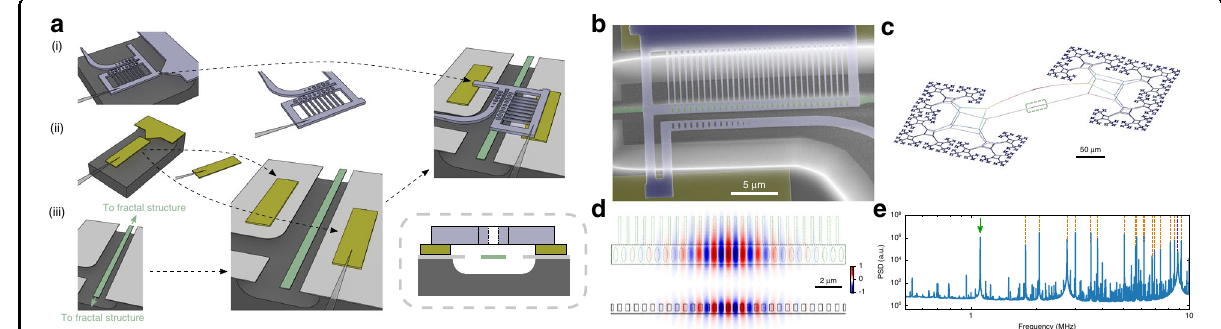
Fig. 1 Optomechanical device. a Device assembly process. We start with three chips, on which the different structures are fabricated from thin fi lm silicon nitride. They are patterned with (i) a photonic crystal, (ii) spacers, and (iii) center part of a mechanical structure, respectively. A fi ber is used to fi rst pick up the spacers and place them on the mechanical chip. Then the photonic crystal is stacked on top of the spacers. The sketch in the box at the bottom-right shows the cross-section of the fully assembled structure. The thickness of the spacers determines the gap distance between the photonic crystal and the mechanical resonator. b False-colored SEM image of the assembled device. c Simulation of the fundamental out-of-plane mechanical mode of the fractal structure. The mechanical motion is gradually damped from the center to the clamping points. The green dashed box highlights the part of the mechanical structure shown in ( a ) and ( b ). d Electric fi eld distribution (top) on the upper surface of the mechanical layer and (bottom) on the center vertical plane. The green dashed line on the upper plot shows the projection of the photonic crystal. The mechanical layer in the simulation has a width of 1 µm, matching the width of the photonic crystal. e Measured power spectral density (PSD) of an assembled device, showing how clean the spectrum is around the fundamental mode, with negligible excess noise from other modes. The PSD is measured using a balanced homodyne detection scheme. The green arrow indicates the fundamental high-Q M mechanical mode, the orange dashed lines the higher mechanical modes, while the mechanical mode of the photonic crystal is marked in purple. All other peaks are either electronic noise or mixing between modes in the read-out